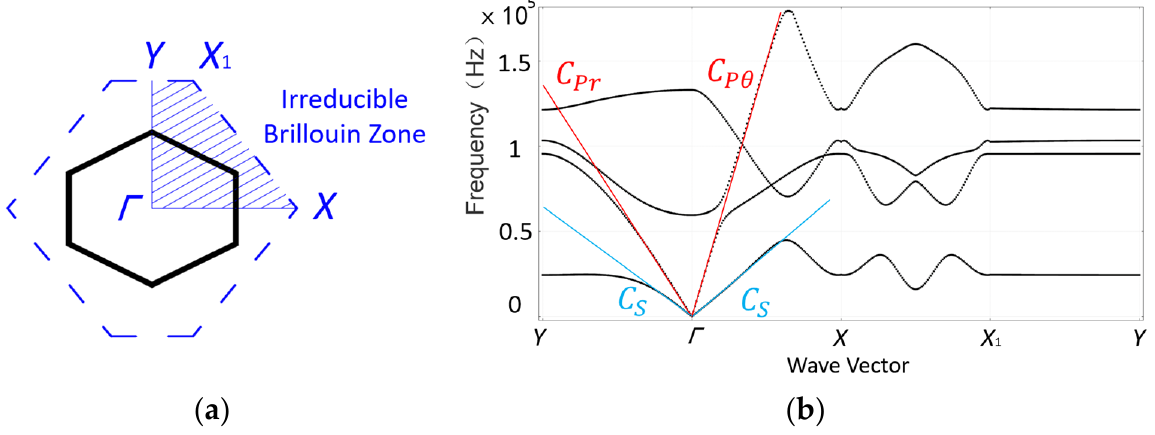
Figure 9. Dispersion characteristics of cells. ( a ) Irreducible Brillouin zone of cells; ( b ) dispersion curves of cells.